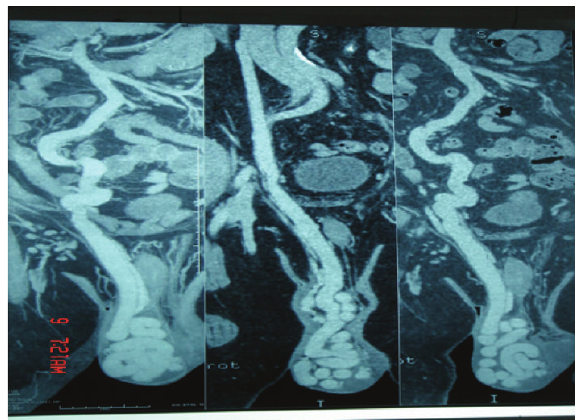
Figure 1: CT angiography showing right testicular vein draining into inferior vena cava and abnormal communication with superior mesenteric vein.